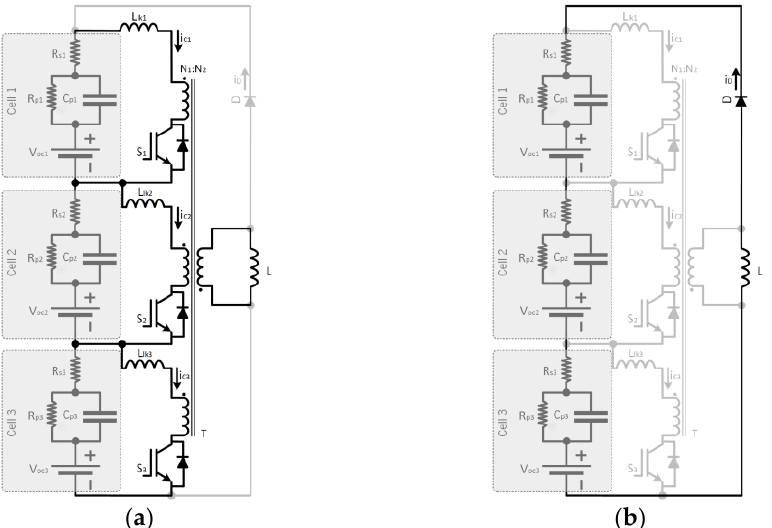
Figure 20. Operating modes of the MWT converter: ( a ) first stage, T 1 ; ( b ) second stage, T 2 .